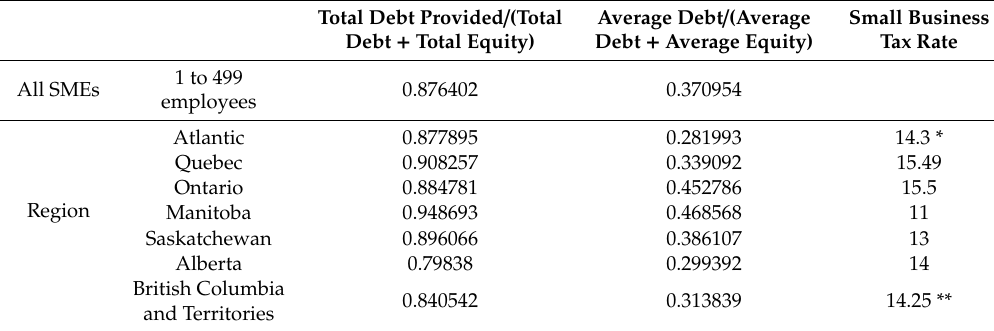
Table 4. Debt and tax rates.